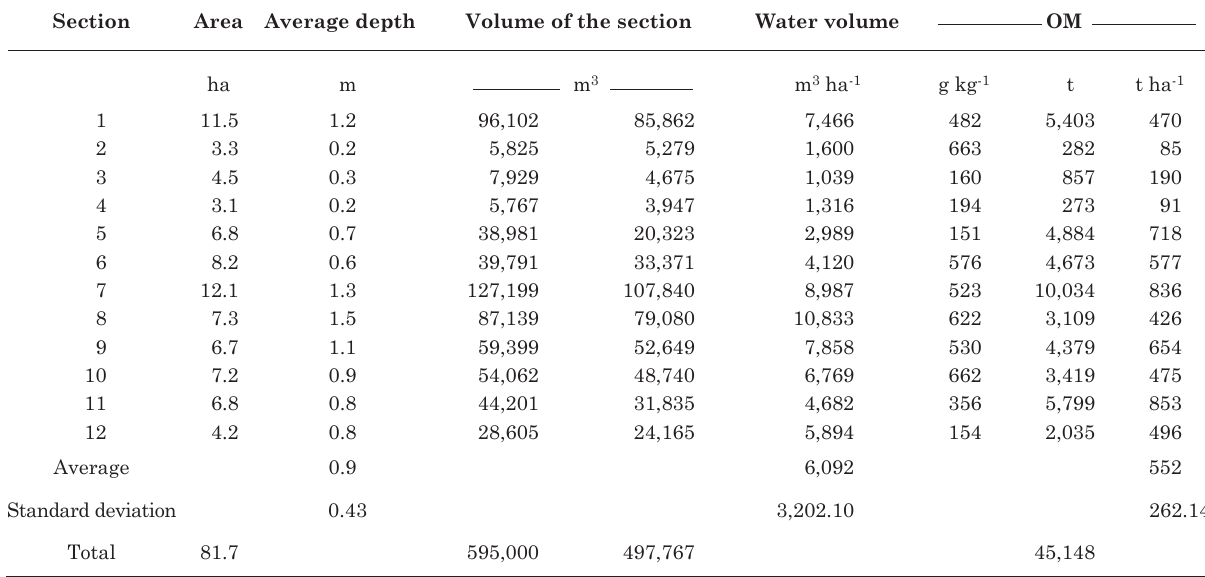
table 3. area, average depth, total volume of water and organic matter (OM) mass in sections of the peatland in the environmental protection area of pau-de-fruta